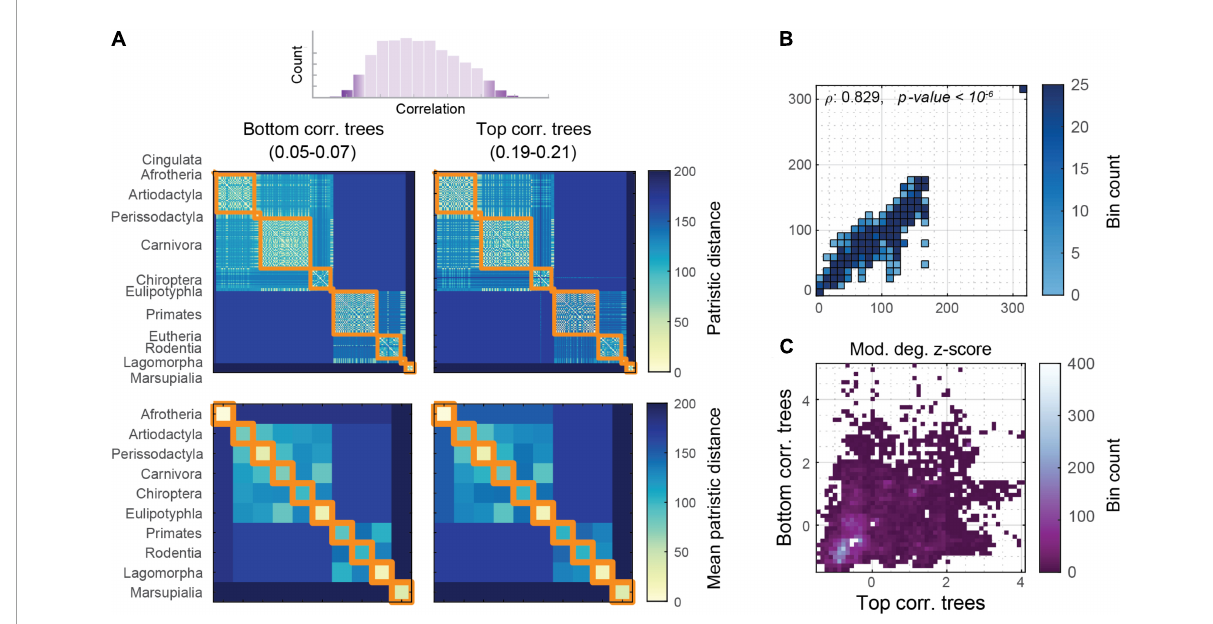
FIGURE5 Phylogenetic distances sampled from the top and bottom of the correlation distribution. (A) Average phylogenetic distances, at mammal level (upper) and taxonomic block (lower) from both the top 1% and bottom 1% of the rank correlation distribution of the network portrait divergence. (B) Correlation between the top and bottom phylogenetic distance matrices, showing generally strong rank correlation. (C) Within-module degree z-score between the top and bottom phylogenetic distance matrices, showing that lower z-scores (below zero) are generally similar, whereas larger z-scores have a greater